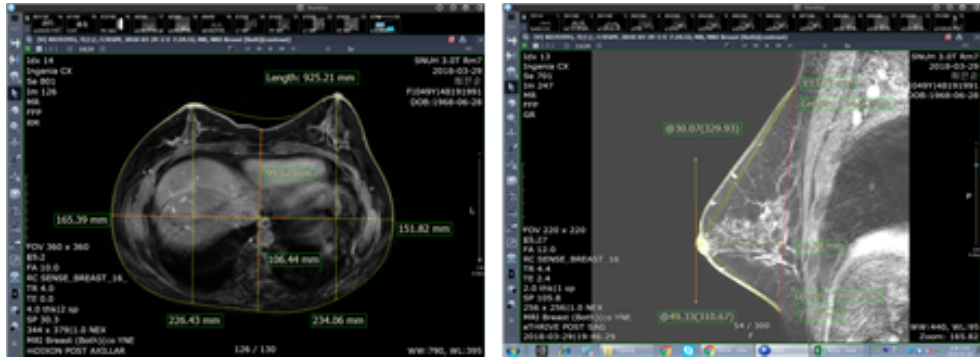
Figure 2. Measurement of detailed items of breasts using PACS.